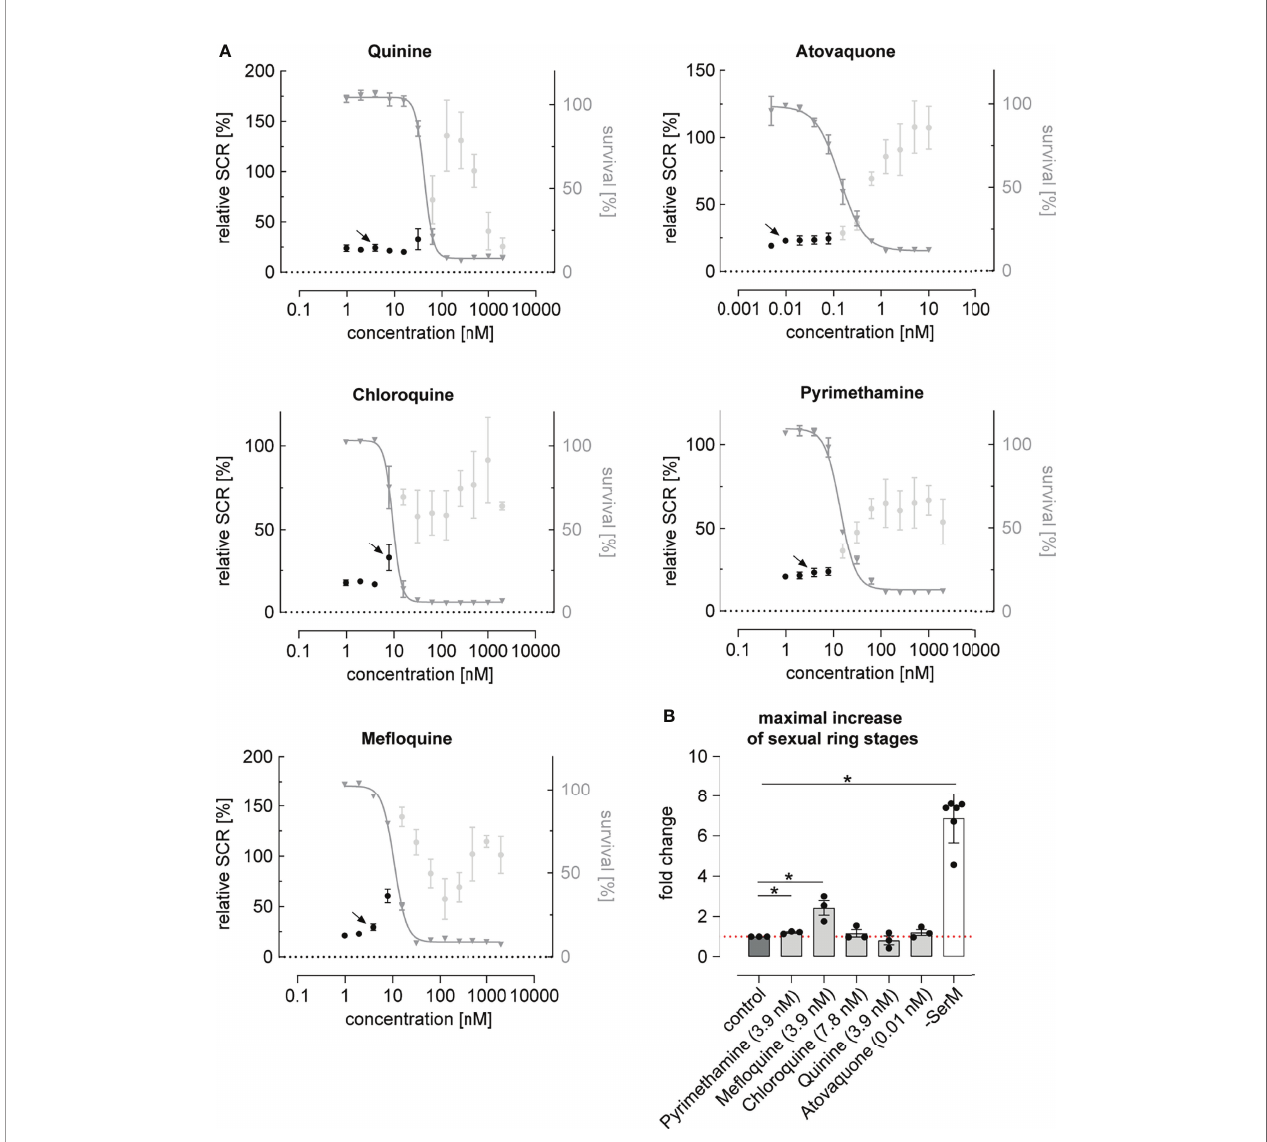
FIGURE 2 | Dose-response relationship between antimalarial compounds and parasite sexual commitment. (A) Antimalarials show a general trend towards increasing the proportion of sexually committed parasites at growth-inhibiting concentrations. Mean parasite survival rates and SCRs are indicated by grey triangles and black bullets, respectively. Grey bullets represent SCRs at compound concentrations above the IC50. Values are normalized to the corresponding control conditions (-SerM for SCR) and (-SerM/choline for survival). Data points represent the mean of three independent biological replicate experiments. Error bars represent the standard error of the mean. Arrows indicate data points used for the calculation of SCR fold-changes shown in (B) . (B) Exposure to sub-therapeutic me fl oquine concentrations result in an absolute increase of sexually committed ring stage progeny formed. Pyrimethamine shows a similar but markedly less pronounced effect. Bars indicate mean fold changes of sexual ring stage formation compared to untreated control conditions (-SerM/choline/DMSO), with black . For each drug, the results bullets representing fold changes from individual biological replicates. Fold changes are de fi ned as survial ( testcondition ) * SCR ( testcondition ) survial ( controlcondition ) * SCR ( controlcondition ) shown are derived from the concentration for which the maximal net increase in absolute sexual ring stage formation was observed. Drug concentrations are indicated. -SerM shows the effect of choline depletion on sexual ring stage formation. Asterisks mark signi fi cant differences (p-value < 0.05; paired two-tailed Student ’ s t-test). n=3; error bars represent the standard error of the